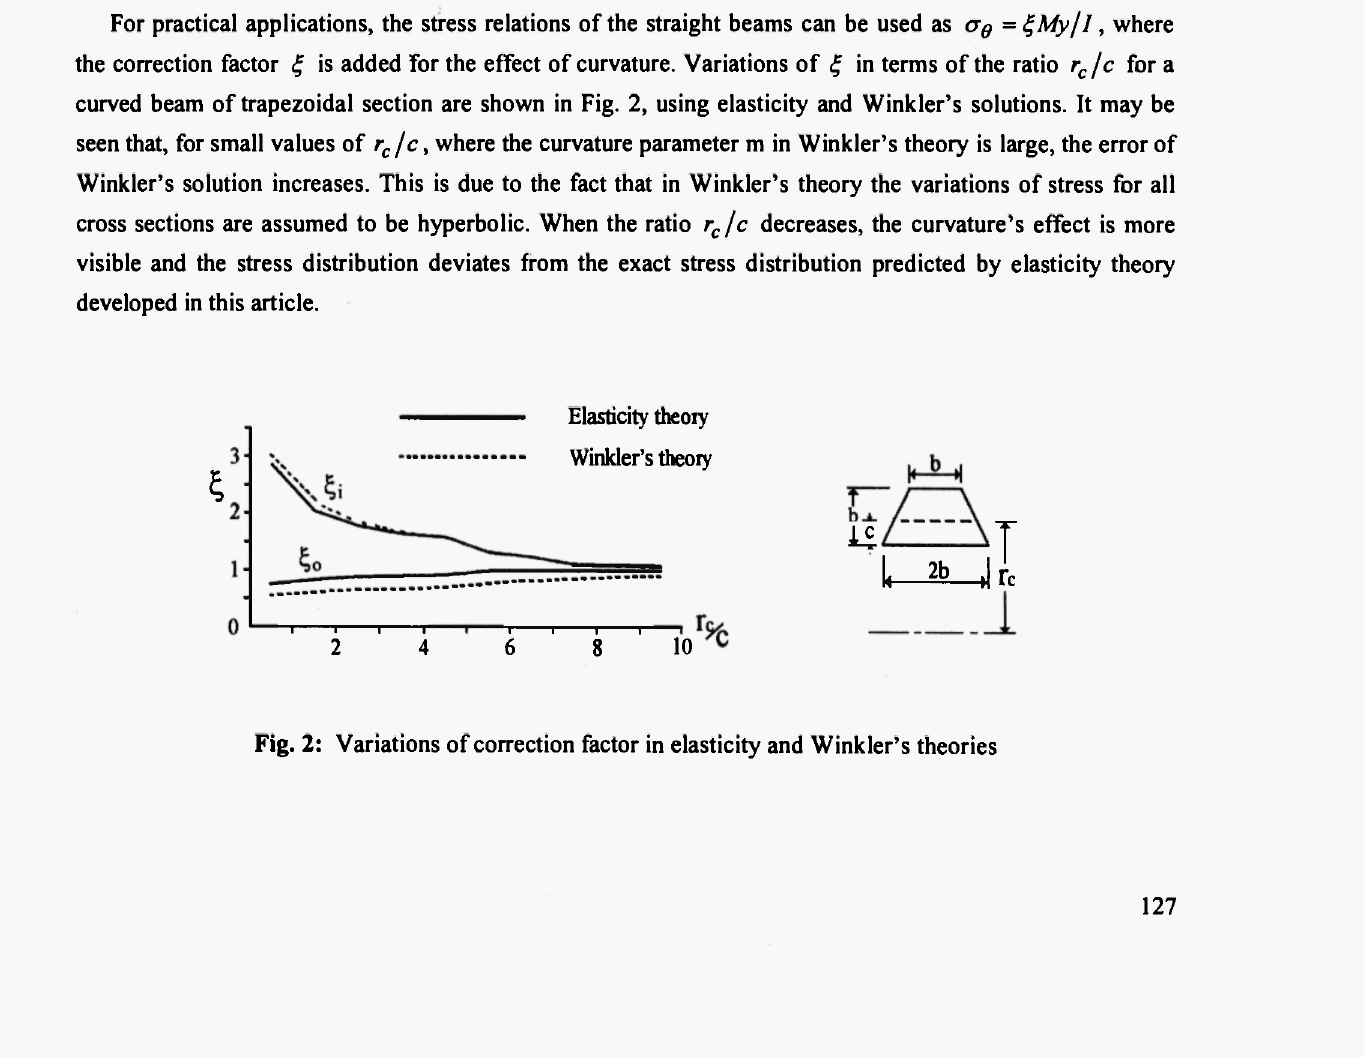
Fig. 2: Variations of correction factor in elasticity and Winkler's